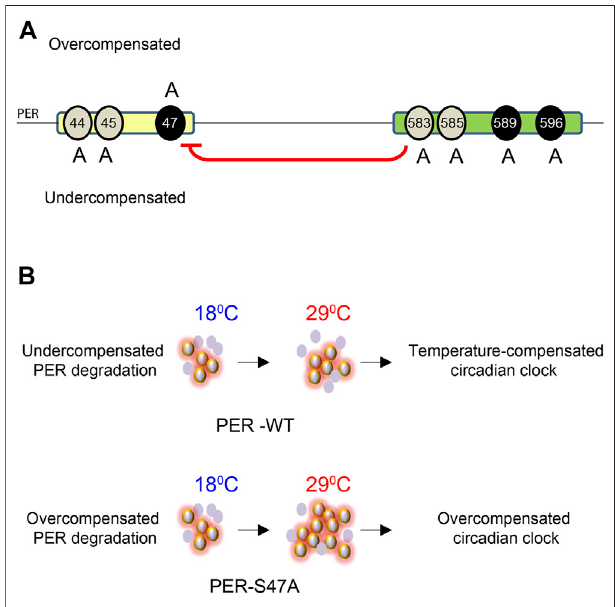
FIGURE 6 | Model for the role of PER phosphoclusters in temperature compensation. (A) The PER phosphodegron (yellow) and per s phosphocluster (green) modulate temperature compensation. Mutations of different residues of the PER phosphodegron have opposite effects on temperaturecompensation.S44AandS45Acauseundercompensationwhile S47A results in overcompensation of circadian period. Mutations in the per s phosphocluster cause undercompensation, consistent with its inhibitory role on S47 phosphorylation (red arrow). Black ovals around 47, 589, and 596 show DBT and NMO mediated phosphorylation sites on PER. Grey ovals around 44, 45, 583, and 585 depict putative additional phosphorylation sites. (B) S47 action on temperature compensation. In wild-type fl ies, PER abundance and rate of PER degradation increase with increase in temperature. Hyper- and hypo-phosphorylated isoforms remain in balance and the clock is properly temperature-compensated, presumably because of S47 phosphorylation. In S47A mutant fl ies, PER degradation is overcompensated and thus slows down at high temperature, leading to excessiveaccumulationofhyperphosphorylatedisoforms.Thisispredictedto prolong repression of CLK/CYC-transcription and thus lengthened period (Kivimäe et al., 2008). The clock is then overcompensated. Violet ovals represent PER protein, Halo around violet ovals show hyper- phosphorylated